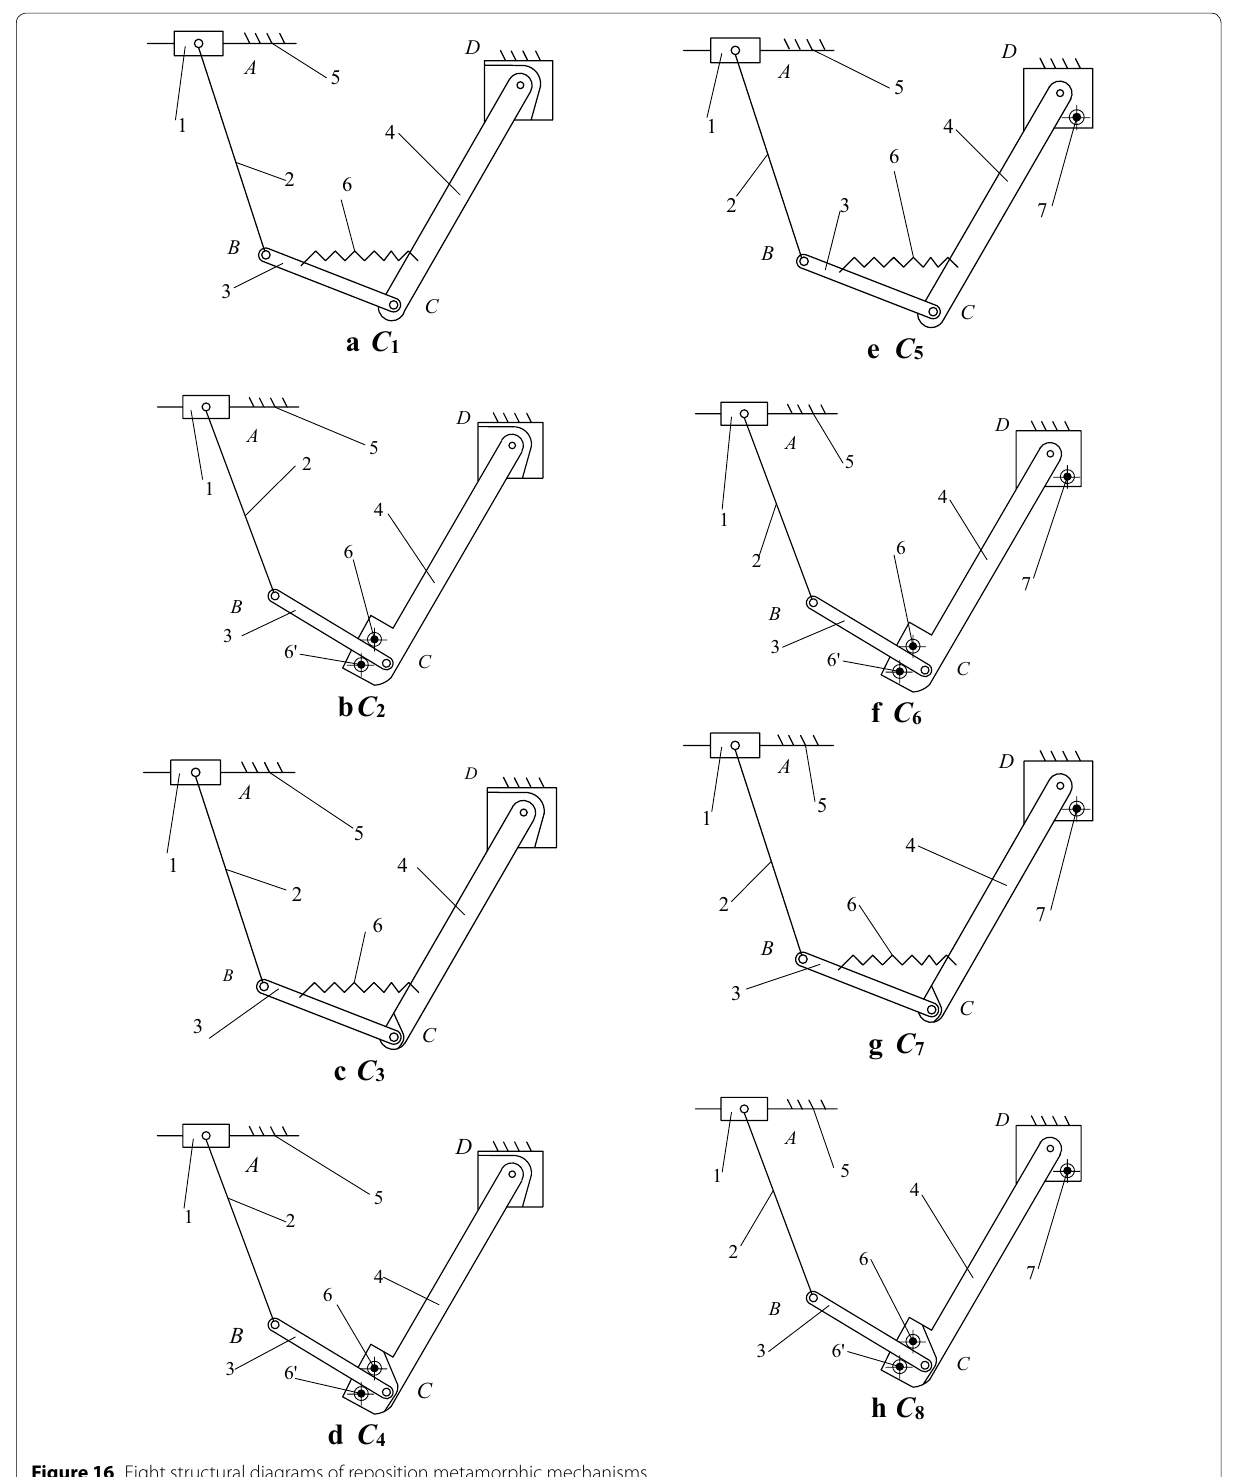
Figure 16 Eight structural diagrams of reposition metamorphic